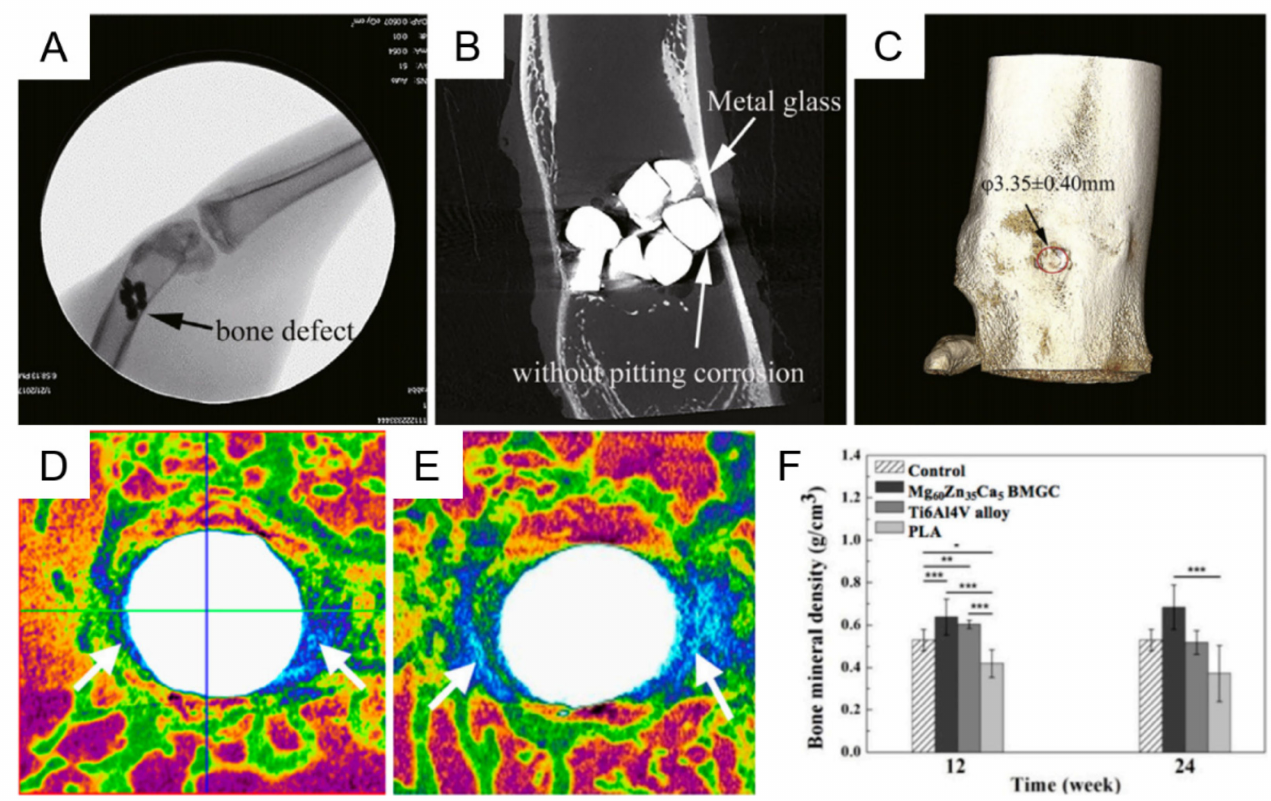
Figure 5. X-ray ( A ), µ -CT ( B ), and 3D reconstruction photographs ( C ) of Mg 69 Zn 27 Ca 4 MG at 2 months postoperation, reproduced with permission from [54]. Micro-CT image of the rabbit’s femur implanted with Mg 60 Zn 35 Ca 5 MGMC at 12 ( D ) and 24 ( E ) weeks postoperatively. ( F ) Intergroup comparison of bone mineral density surrounding the implanted site at 12 and 24 weeks, analyzed with CTan analyzer software (* p < 0.05, ** p < 0.01, *** p < 0.001)